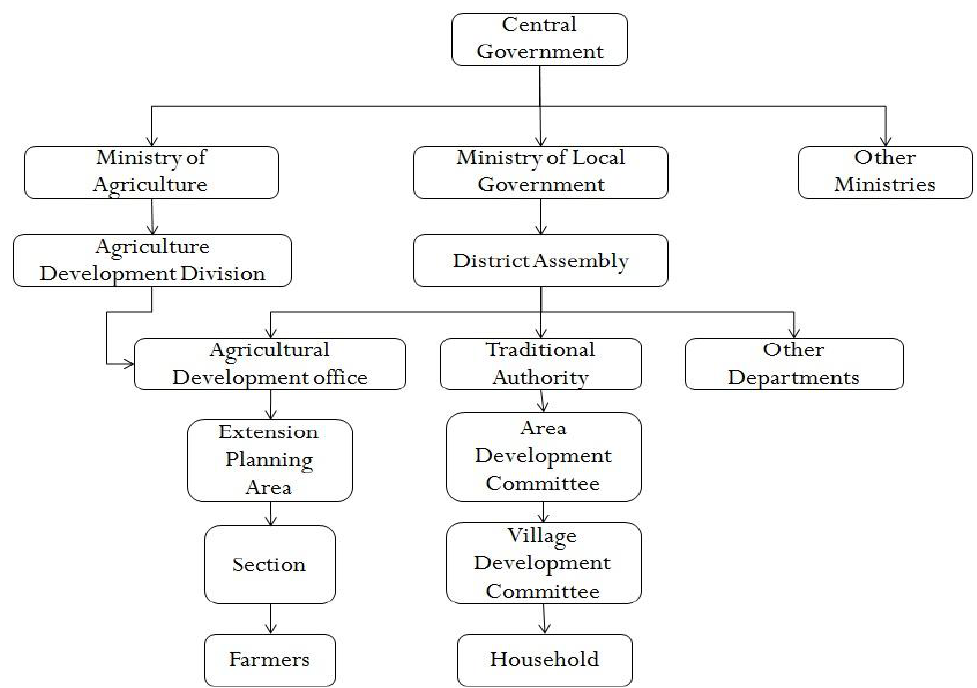
Figure 3. District/town assembly organizational